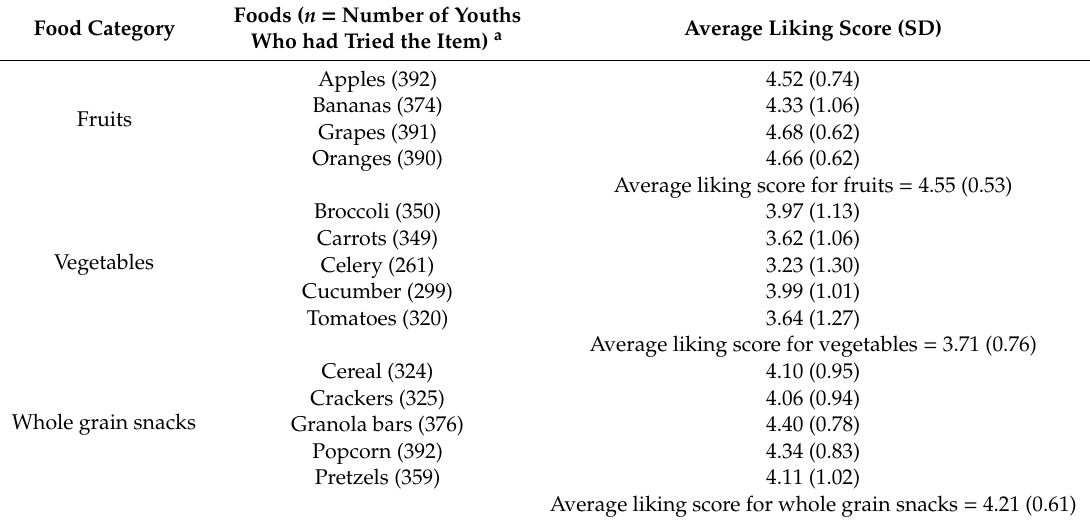
Table 2. Average liking scores for specific fruits, vegetables, and whole grain snacks based on a 5-point labeled hedonic scale (scored 1 = dislike a lot, scored 2 = dislike, scored 3 = neither like nor dislike, scored 4 = like, scored 5 = like a